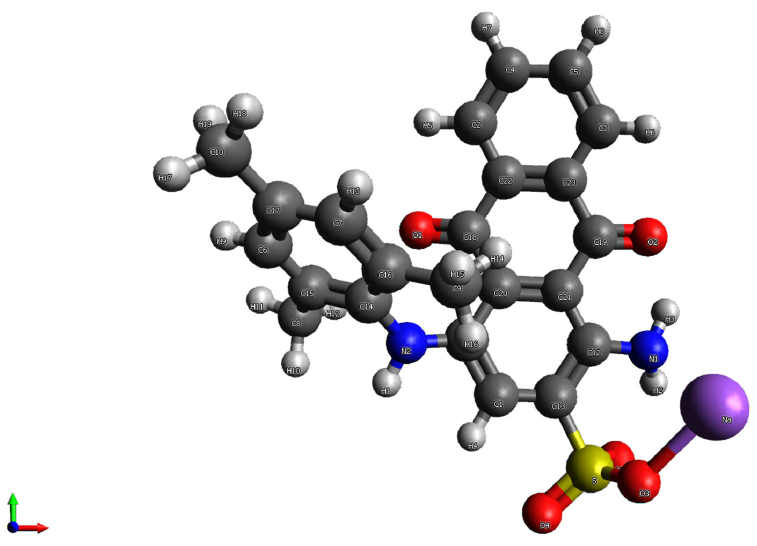
Figure 5. Optimized AB129 molecule obtained using B3LYP/6-31G**.